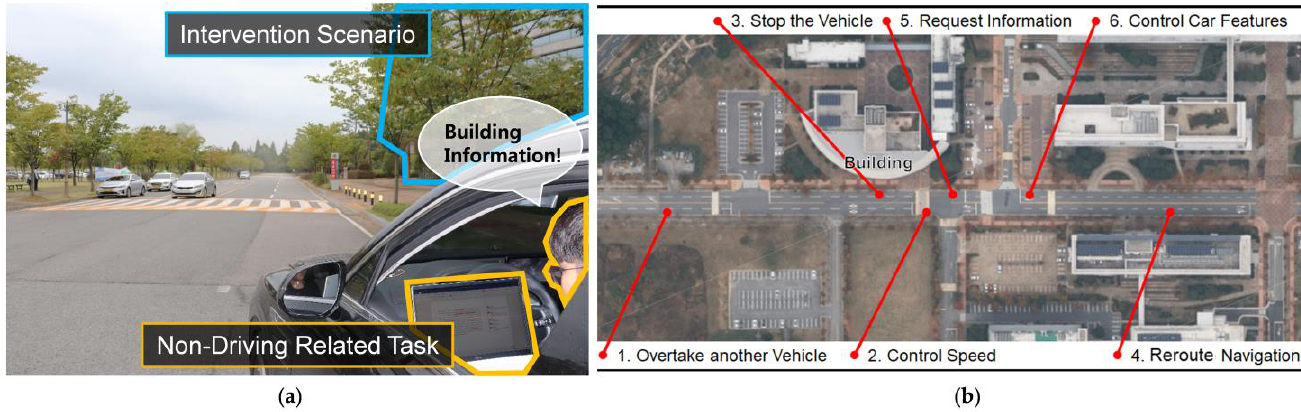
Figure 2. Example snapshot from our video ( a ) showing one intervention scenario (requesting building information) and a driver engaged in an NDRT (working on laptop). ( b ) A map of the routes used to create our survey videos.